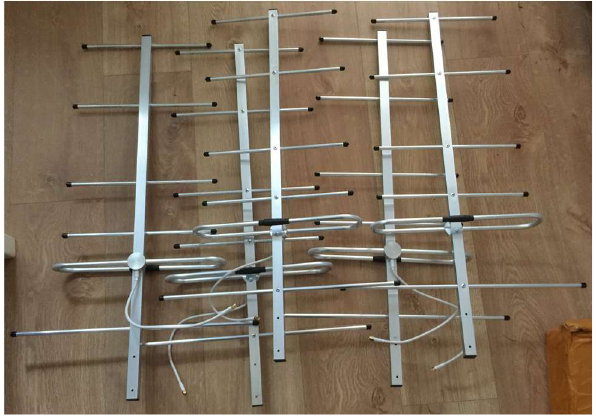
Figure 23. Ground station antennas.